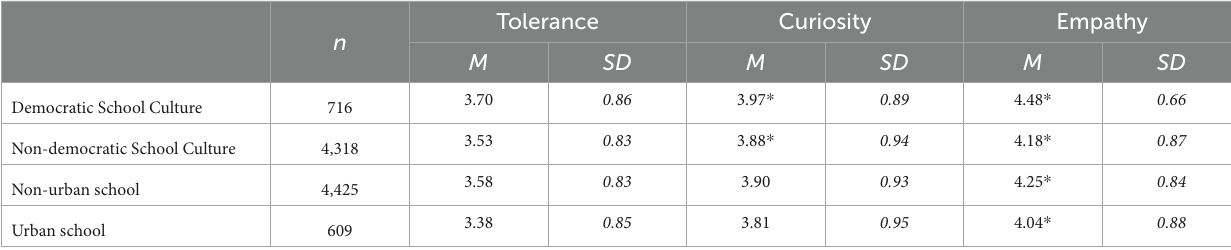
TABLE 3 Descriptive statistics of school-level variables by deliberative